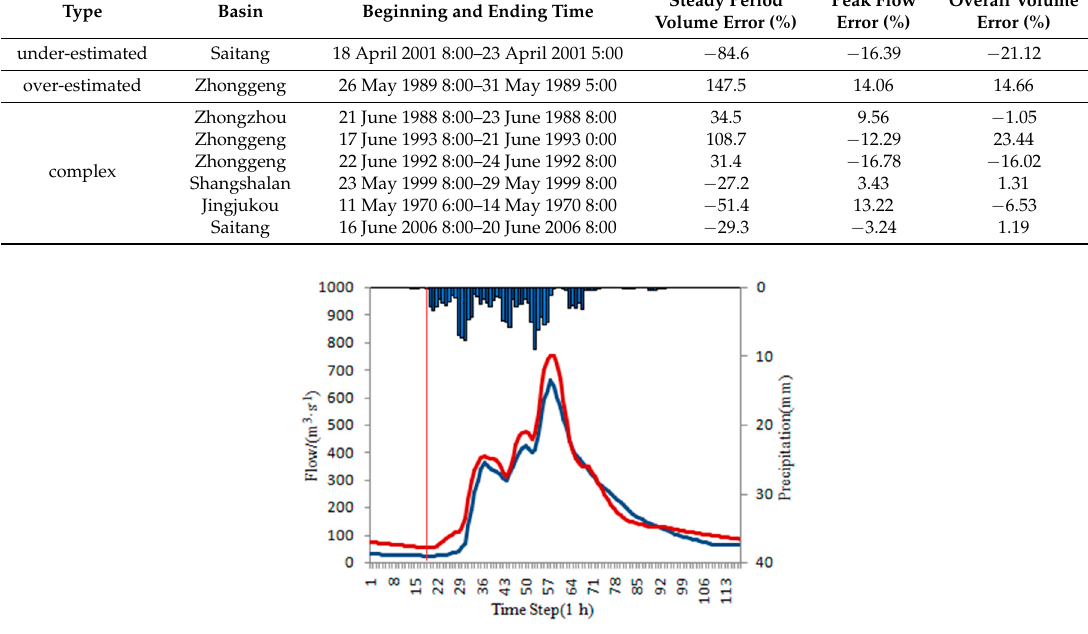
Figure 7. Under-estimated flood.